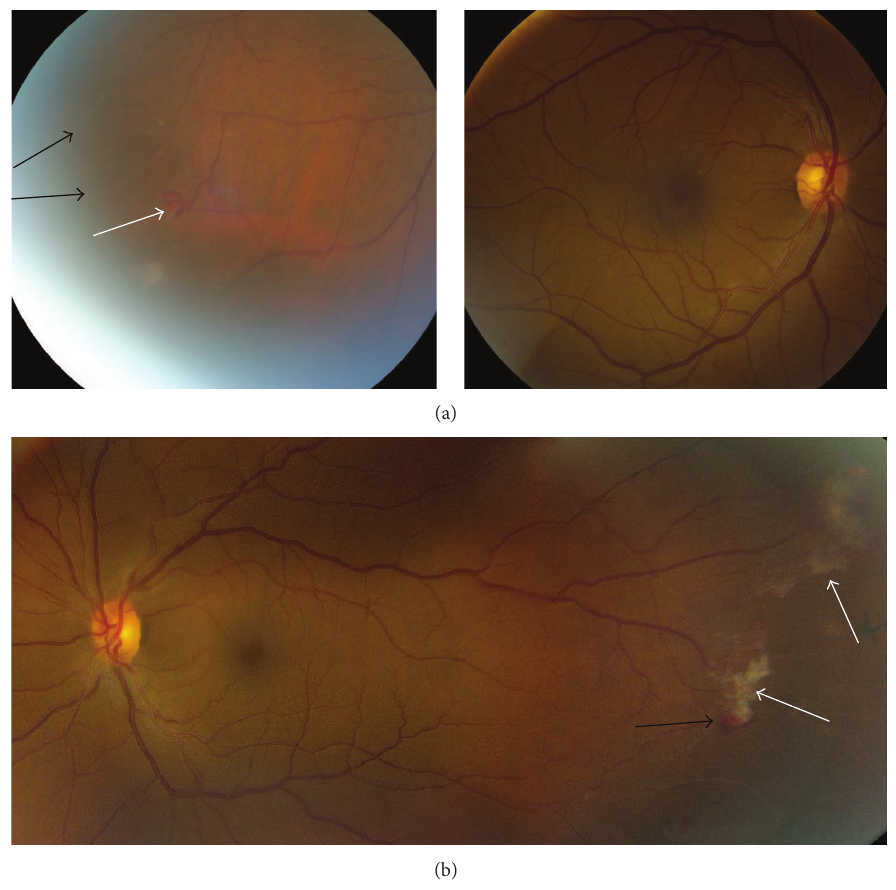
Figure 1: Fundus photography of both eyes. Right eye (a) showing sclerotic occluded vessels (black arrows) and early sea-fan neovascu- larization (white arrow) in the inferotemporal periphery. Left eye (b) shows sea-fan neovascularization (black arrow) with fibrovascular proliferation (white